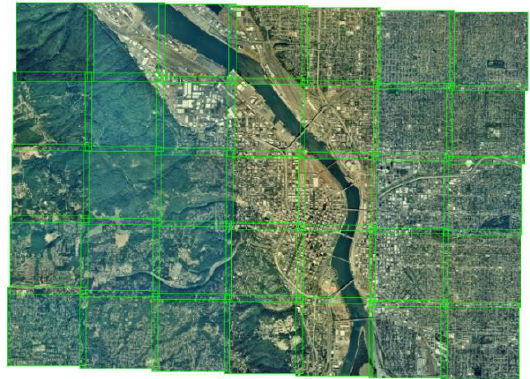
Fig.2.1 Original MD with image footprint before color